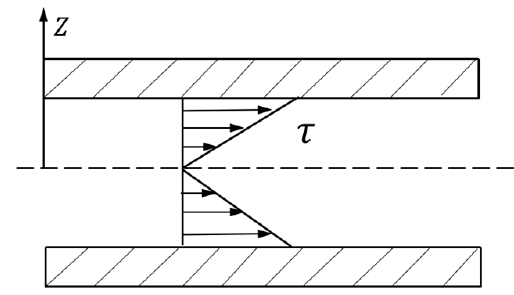
Figure 6. Shear stress distribution in the ERF.